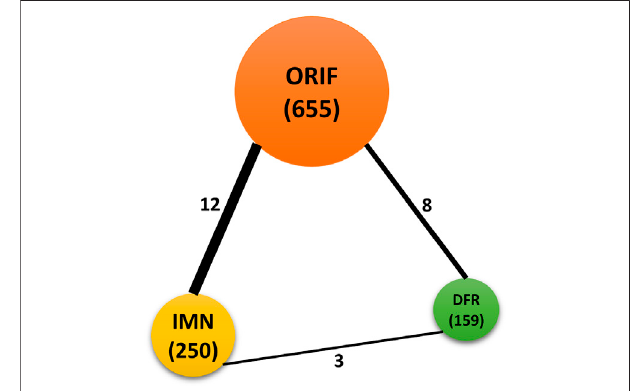
FIGURE 2 | Evidence network of three surgical techniques including ORIF, IMN, and DFR. Circle size is positively corresponding to the accumulated sample size, and the width of the solid line is positively related to accumulated numbers of eligible